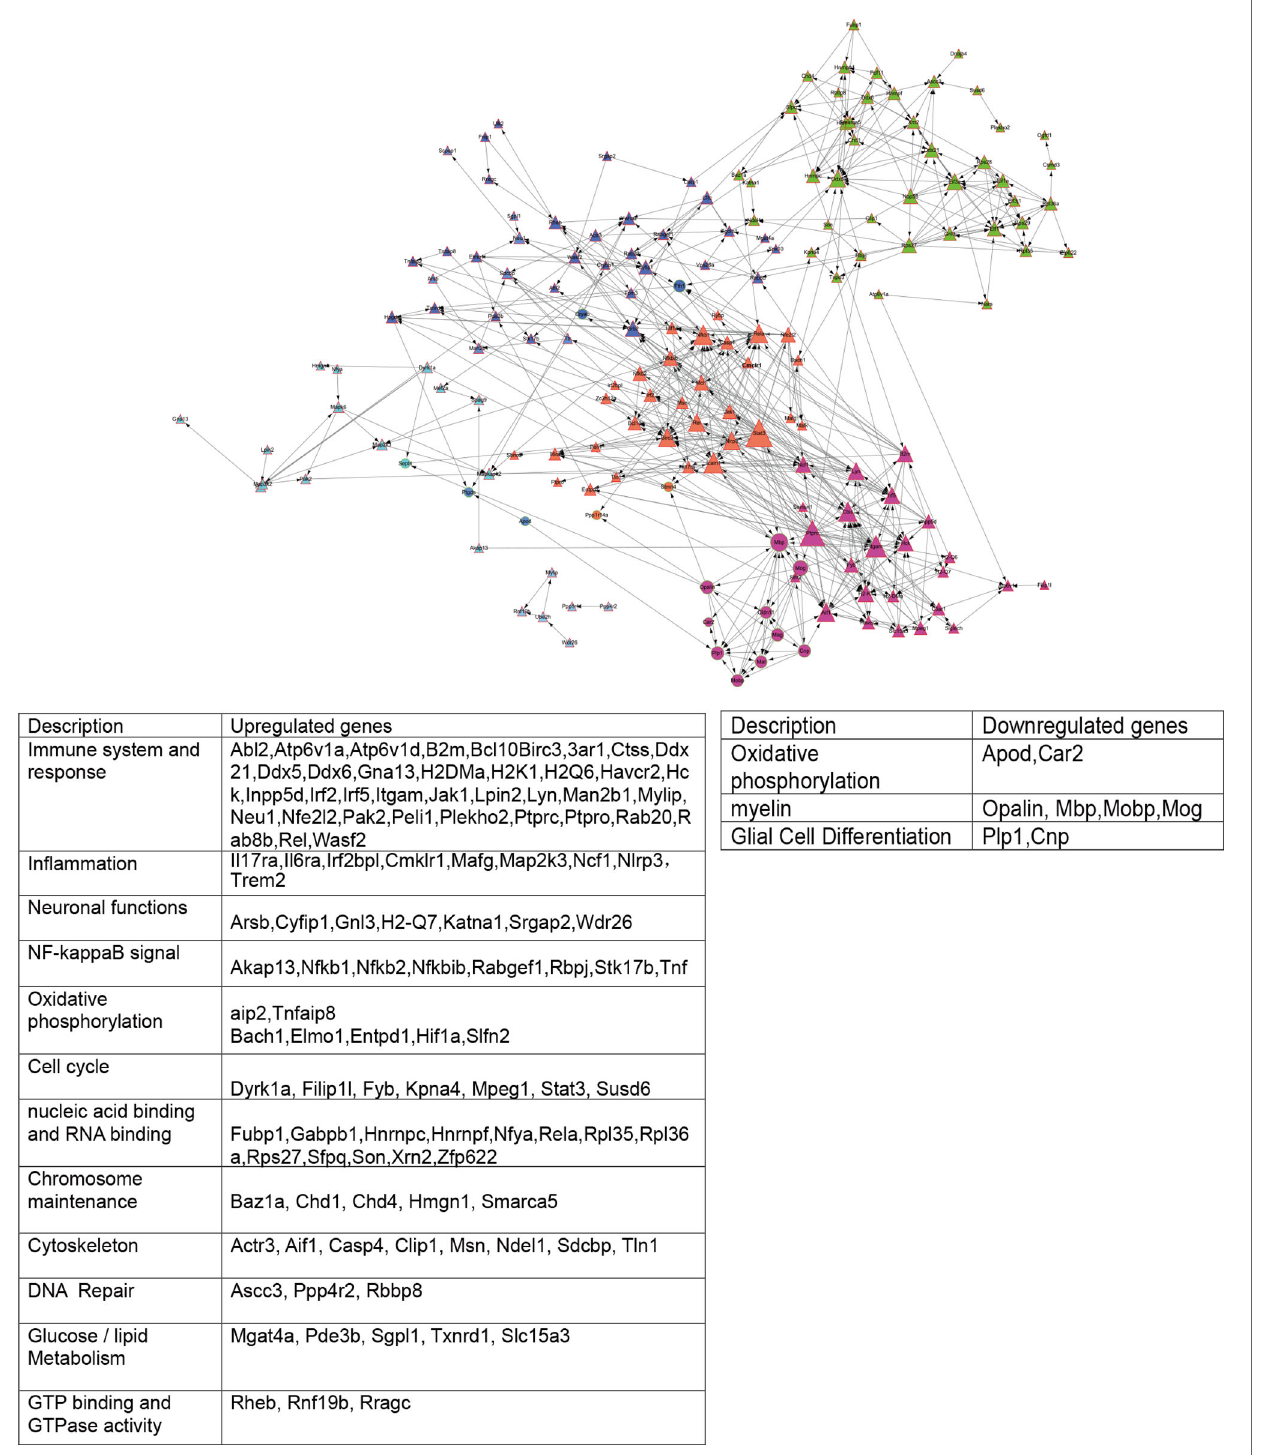
Frontiers in Endocrinology |